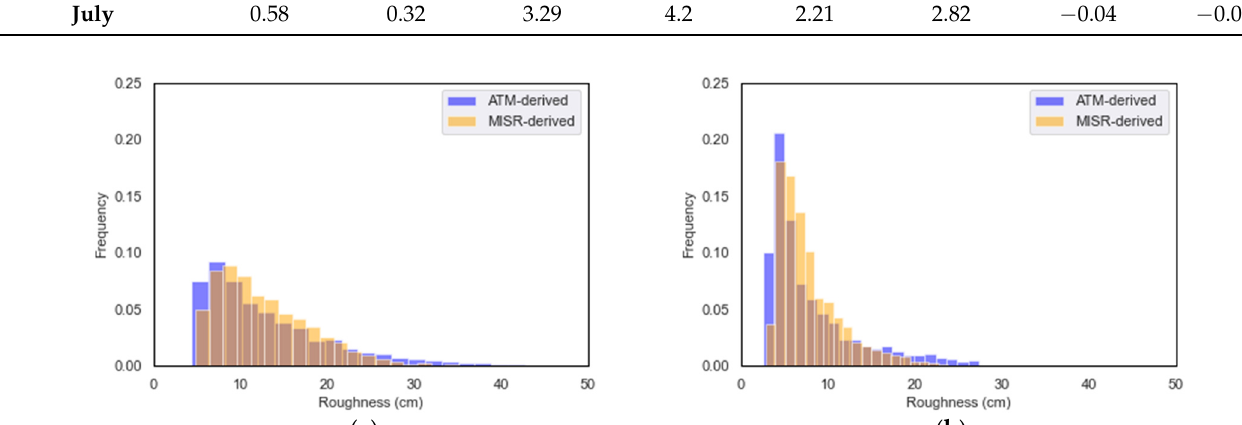
Figure 2. Histograms comparing MISR-estimated (using KNN model) and ATM-observed (independent test data) sea ice roughness for ( a ) April and ( b ) July 2016. The brown color is where the blue and orange colors overlay each other.